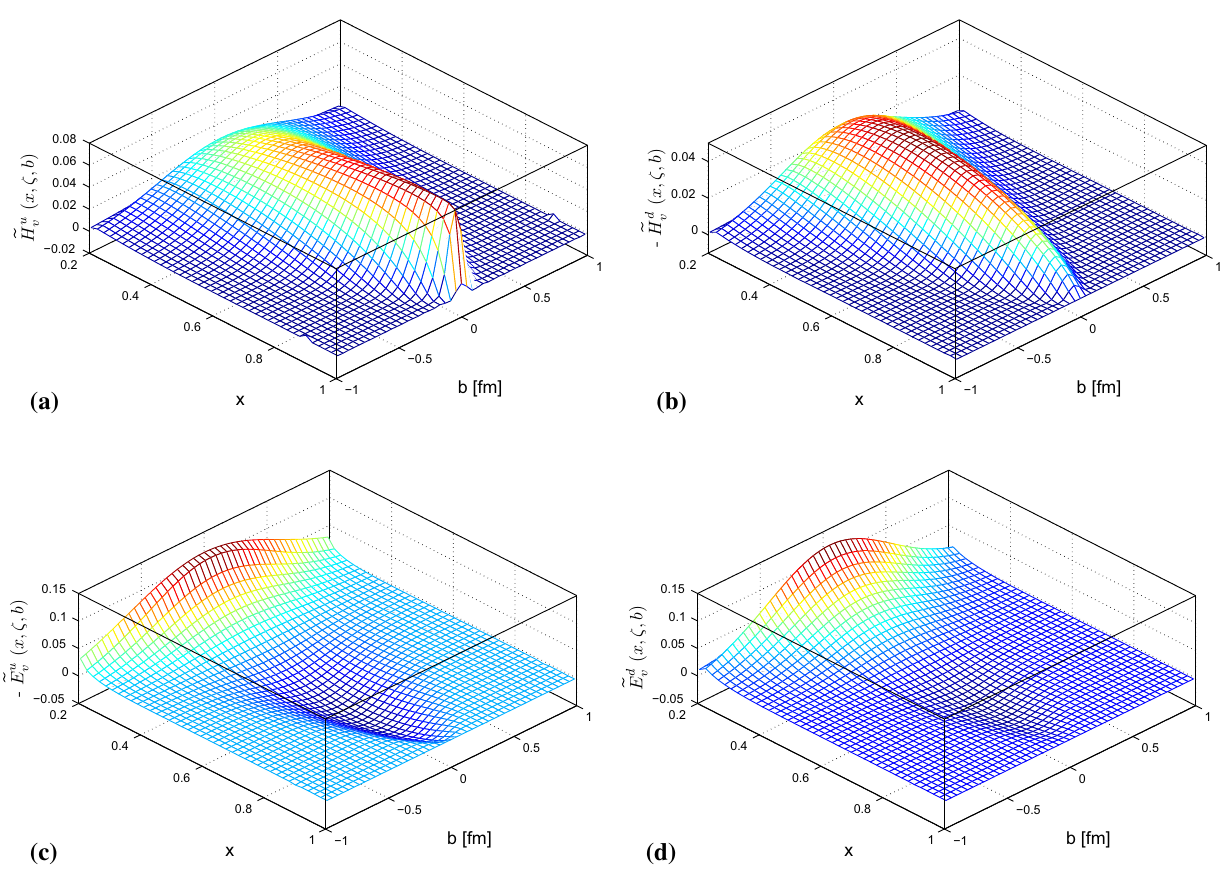
Fig. 6 (Color online) Plots of helicity-dependent GPDs for the nonzero skewness in impact space vs. x and b = | b | for a fixed value of ζ = 0 . 2. The left panel is for the u quark and the right panel is for the d